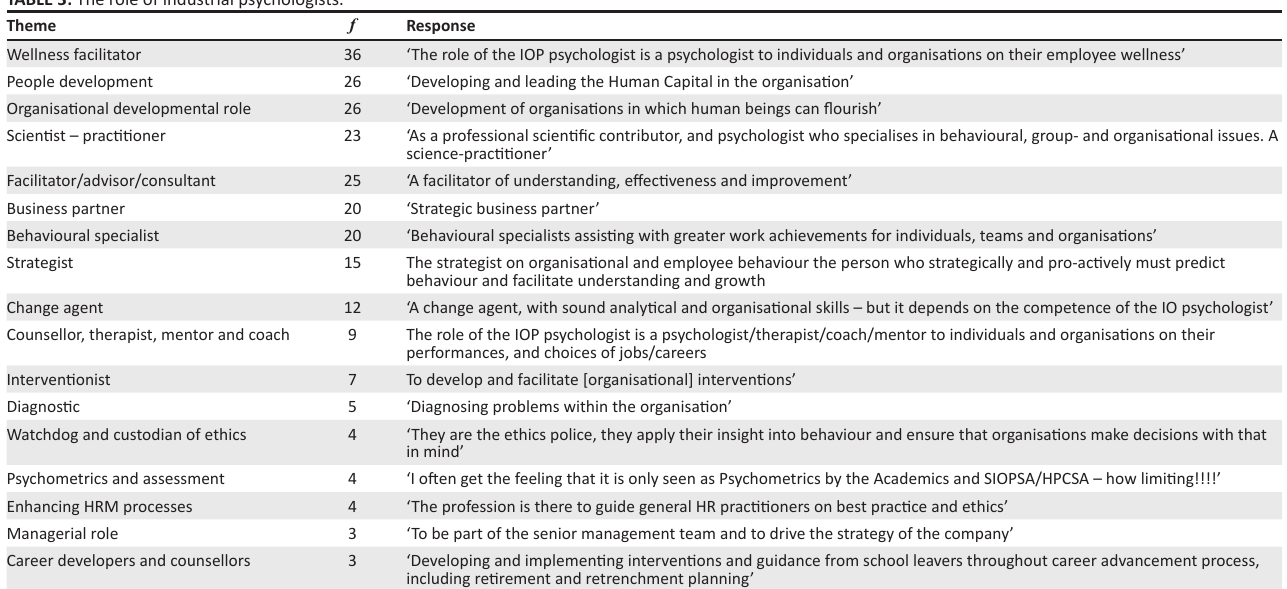
TABLE 3: The role of industrial